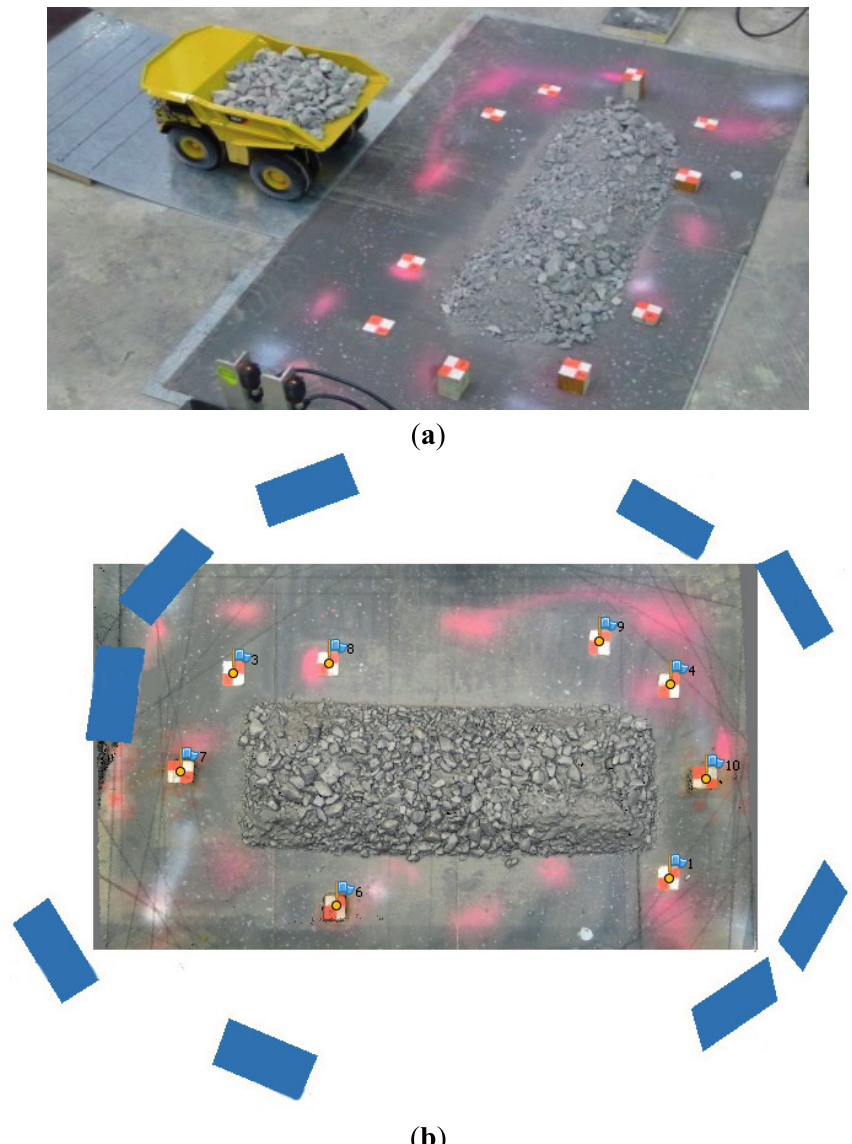
Figure 2. Laboratory-scale tests: ( a ) typical berm with GCP; ( b ) corresponding typical circular image